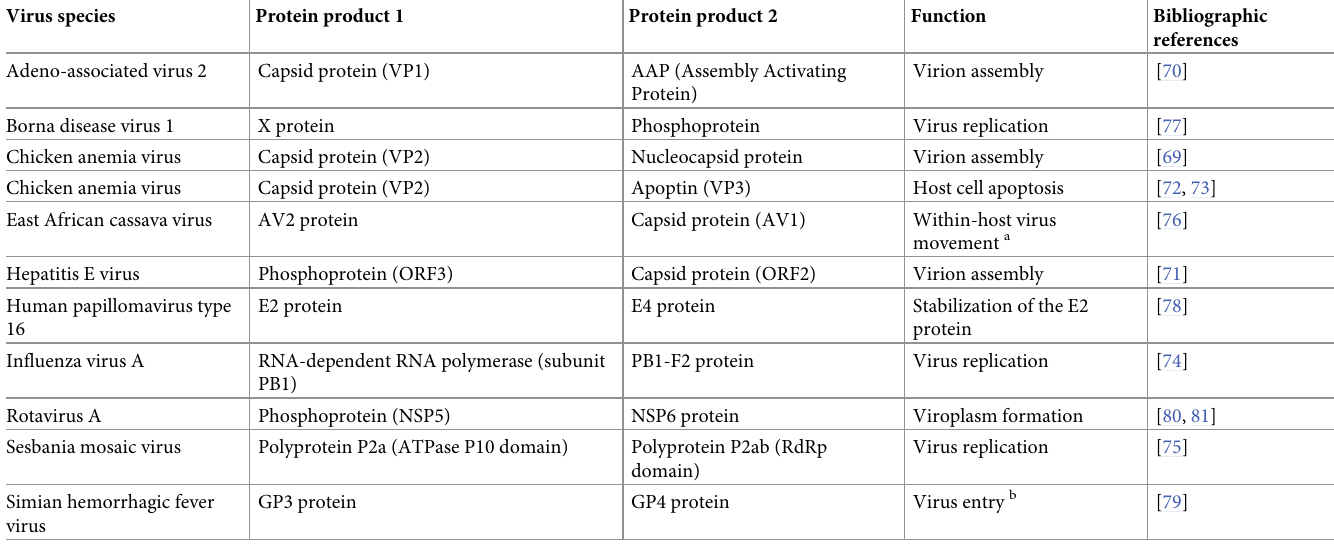
Table 2. List of the 11 pairs of overlapping genes encoding interacting